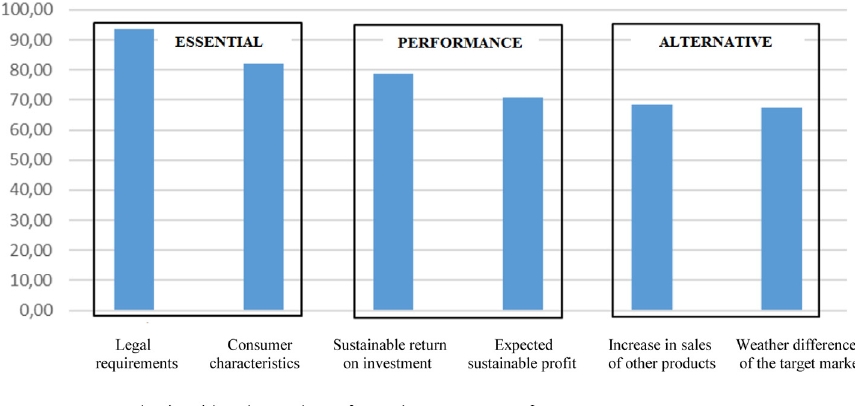
Figure 3. B2B þ B2C ranking and group of